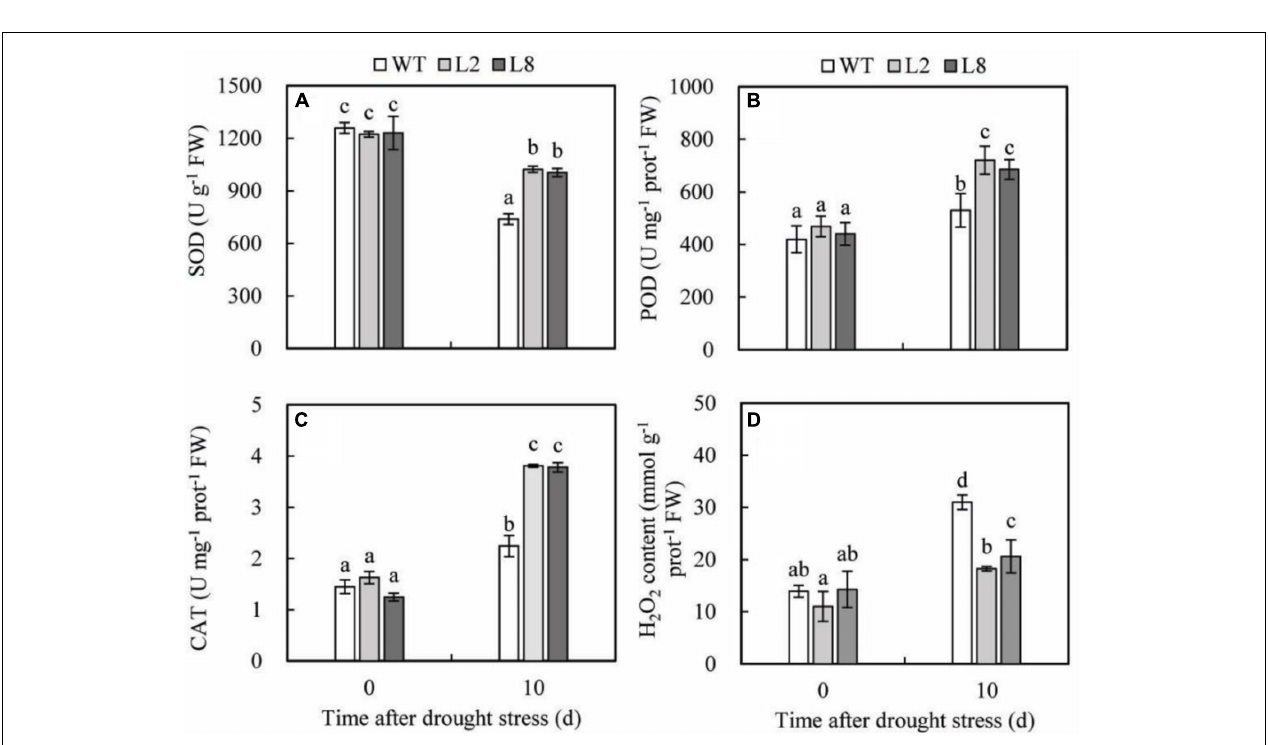
FIGURE 6 | Analysis of the physiological indices in WT and transgenic lines (L2 and L8) under drought stress. Six-week-old seedlings were withheld water for 10 days to measure the value of RWC (A) , water loss rate (B) , proline content (C) and MDA (D) . Error bars represent SD and values with different letters are significant at P < 0.05.